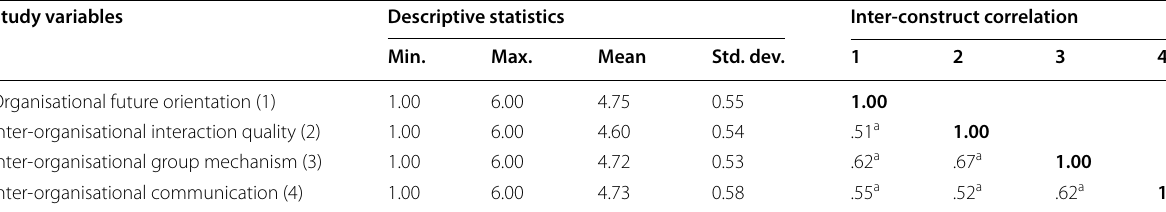
a Correlation is significant at the 0.001 level (2-tailed)